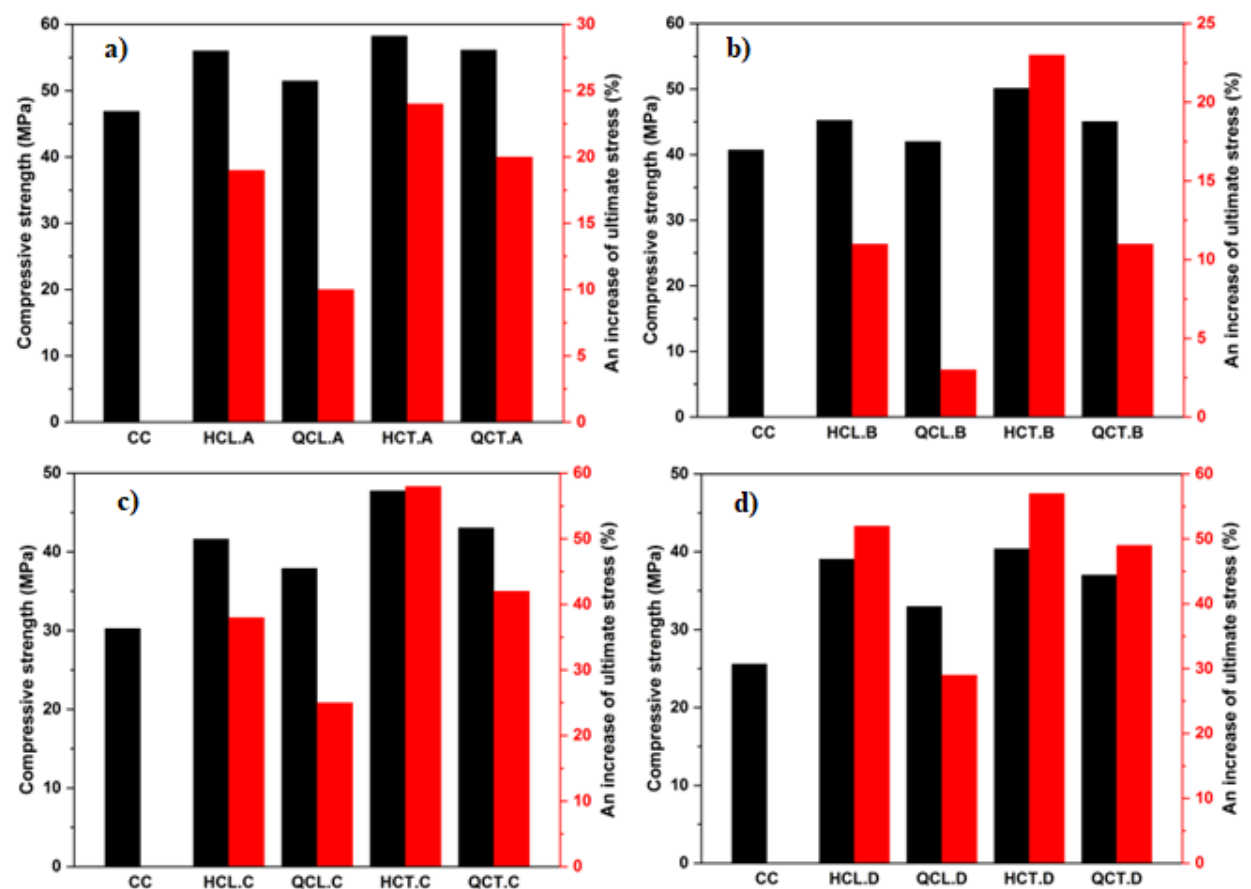
Figure 5. The effect of CFRP orientation: ( a ) concrete made with 0.33 W/C; ( b ) concrete made with 0.36 W/C; ( c ) concrete made with 0.401 W/C; and ( d ) concrete made with 0.522